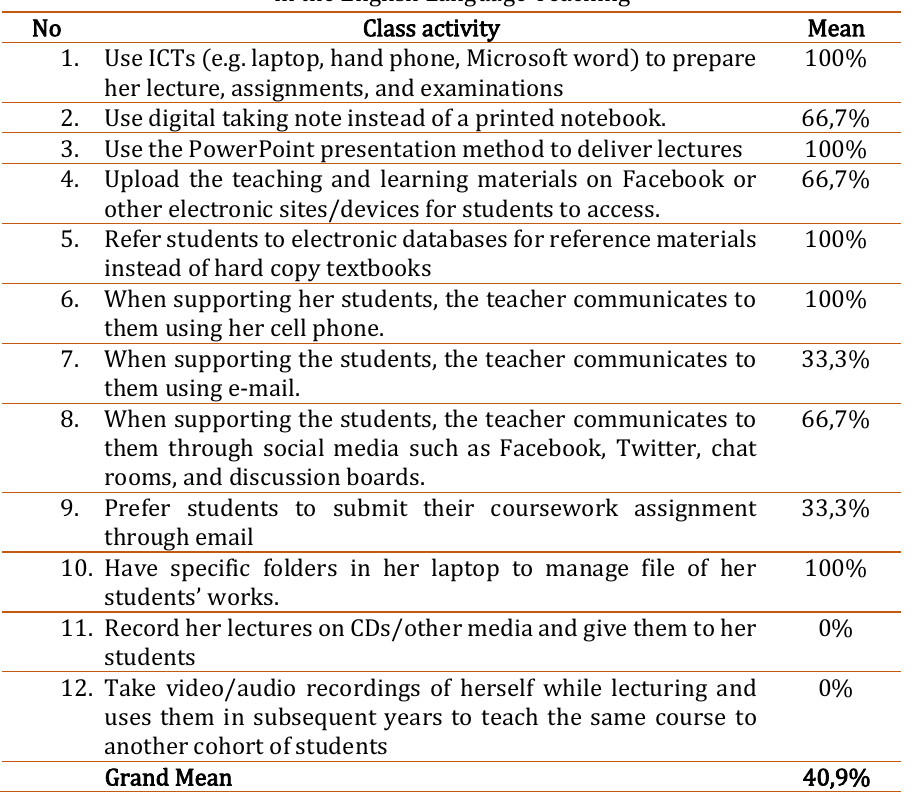
Table 1. Observation table of Substitution ICTs Used by the Teacher